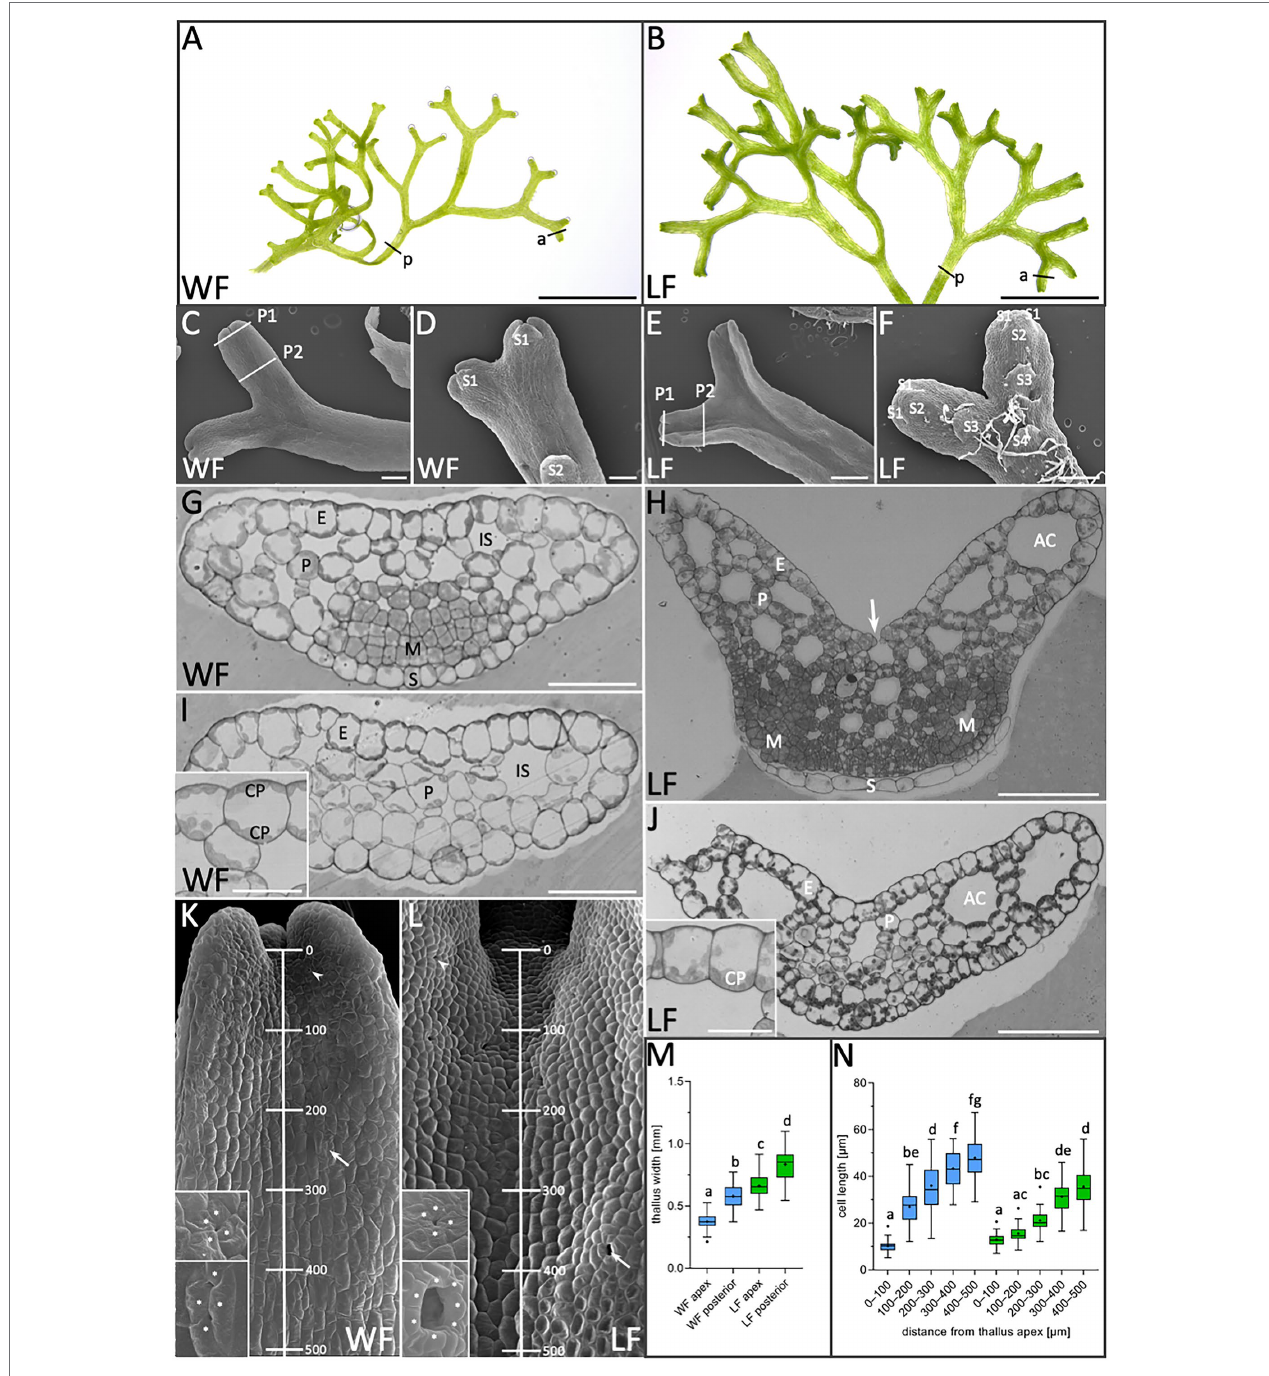
FIGURE 1 | Morphological comparison of R. fluitans water form (WF) and land form (LF) thalli. (A) WF and (B) LF plant habitus. (C) WF dorsal, (D) ventral thallus side and (E , F) respective LF thallus sides. P1, P2: Sectioning planes of younger meristematic (P1) and older differentiated thallus tissue (P2). Positions of the youngest (S1) and successively older ventral scales (S2, S3, and S4) are indicated. (G , H) WF and LF cross sections through P1 and (I , J) through P2. Insets in (I , J) show details of epidermal cells. Arrow in (H) indicates an air pore opening. (K , L) Dorsal view on WF and LF thalli indicating the 500 μ m range from the apical notch toward the posterior thallus used for cell length quantification. Arrowheads point to young air pore invaginations (upper insets) and arrows to an arrested older WF pore (lower inset) in (K) and a mature, open LF pore (lower inset) in (L) . Pore ring cells are marked by asterisks according to probable cell borders. (M) Quantification of thallus width at WF (blue) apices (a in A; n = 123, 10 plants) and posterior regions (p in A; n = 60, 15 plants). LF (green) apex (a in B; n = 109, 10 plants) and posterior regions (p in B; n = 60, 15 plants). Letters above columns indicate p < 0.0001. (N) Quantification of WF (blue) and LF (green) cell length ( n = 50 cells, four thalli/form, p < 0.0001) in the five regions indicated in (K , L) . E, epidermis cell; P, parenchyma cell; IS, intercellular space; AC, air chamber; M, meristematic cells; S, ventral scale; and CP, chloroplasts. Scale bars: (A,B) 5 mm; (C,D,F) 200 μ m; (E) 500 μ m; (G,I) 50 μ m; (H,J) 100 μ m; and ( I,J insets) 25 μ